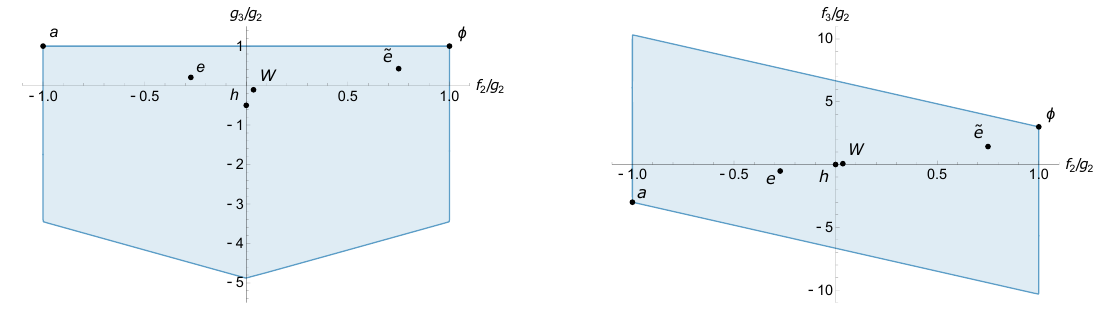
Figure 2 . Bounds on the six-derivative terms f 3 /g 2 and g 3 /g 2 as a function of f 2 /g 2 . The dots refer to the values in the partial UV completions discussed in section 4.4: massive axion ( a ), scalar ( φ )and graviton ( h ), and QED ( e ), scalar QED ( ˜ e ) and W ± sector ( W ).